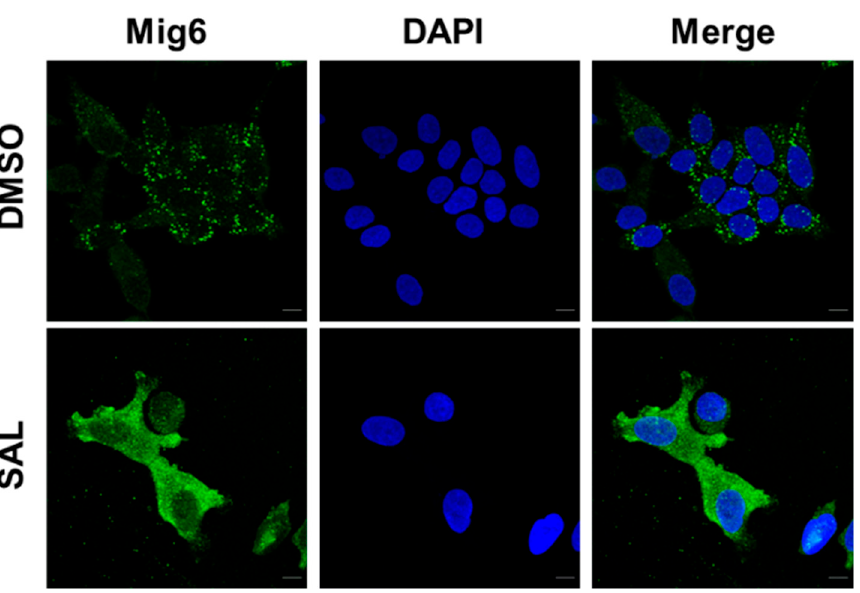
Figure 3. MIG6 levels are enhanced in the cytoplasm upon induction by SAL. Immunofluorescence detection to visualize intracellular localization of MIG6 (green) in LNCaP cells by high-resolution confocal scanning fluorescence microscopy. Nuclei are stained by DAPI (blue). LNCaP cells were treated with DMSO as solvent control or SAL in medium containing 5% FBS for 72 h. DAPI staining was used for staining nuclei. Immunofluorescence using anti-MIG6 antibody, indicates enhanced protein levels being predominantly localized in cytoplasm.